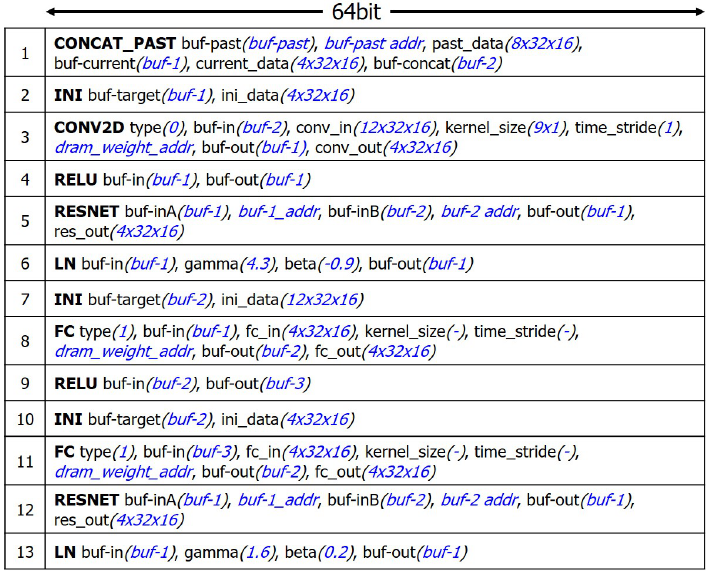
Figure 3. Instruction set for a single TDS operation of the first TDS block in Table 3.